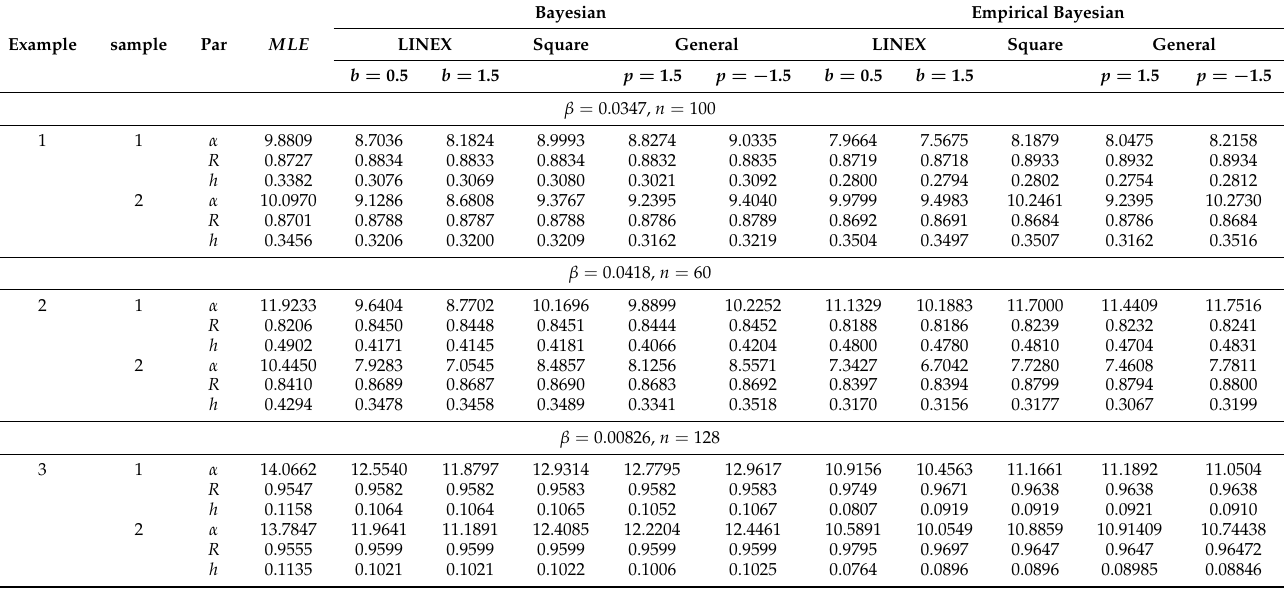
Figure 2. The empirical scaled TTT plot of the simulated data in Table A1. Table 3. Different estimates of the generated adaptive type-I progressively censored samples from three examples under different settings with m = 10 and ω =